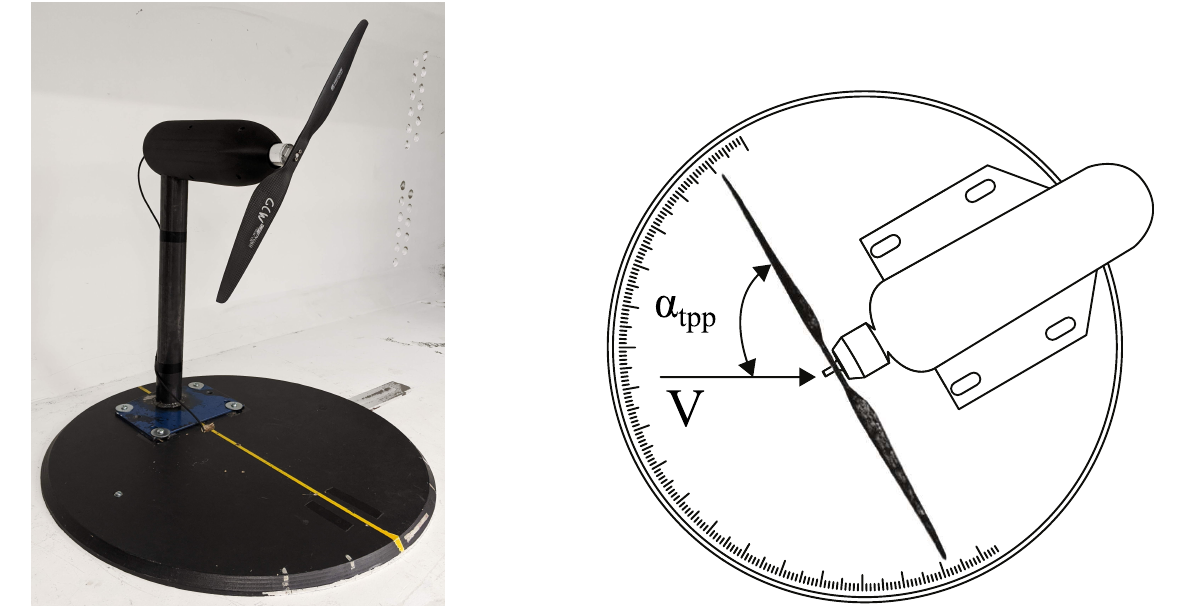
Figure 2. The rotor-test stand configuration and angle of attack convention. ( a ) The rotor-test stand. ( b ) Definition of tip-path plane angle of attack